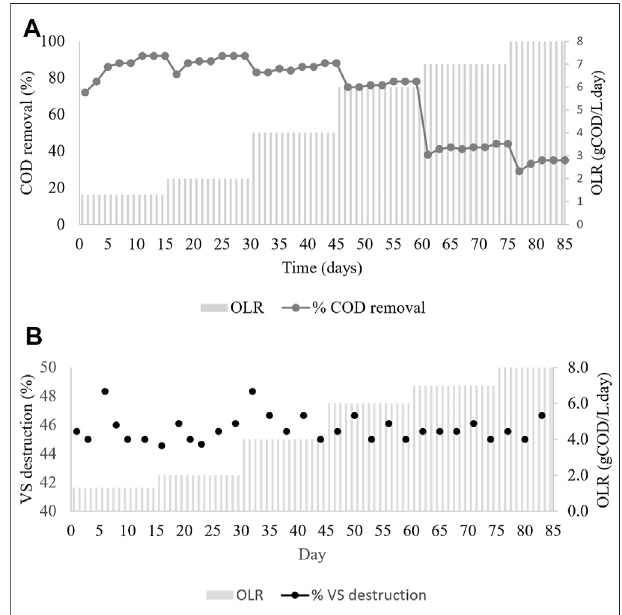
FIGURE 4 | CMFW organic removal ef fi ciency in CSTR. (A) COD removal (B) Volatile Solid